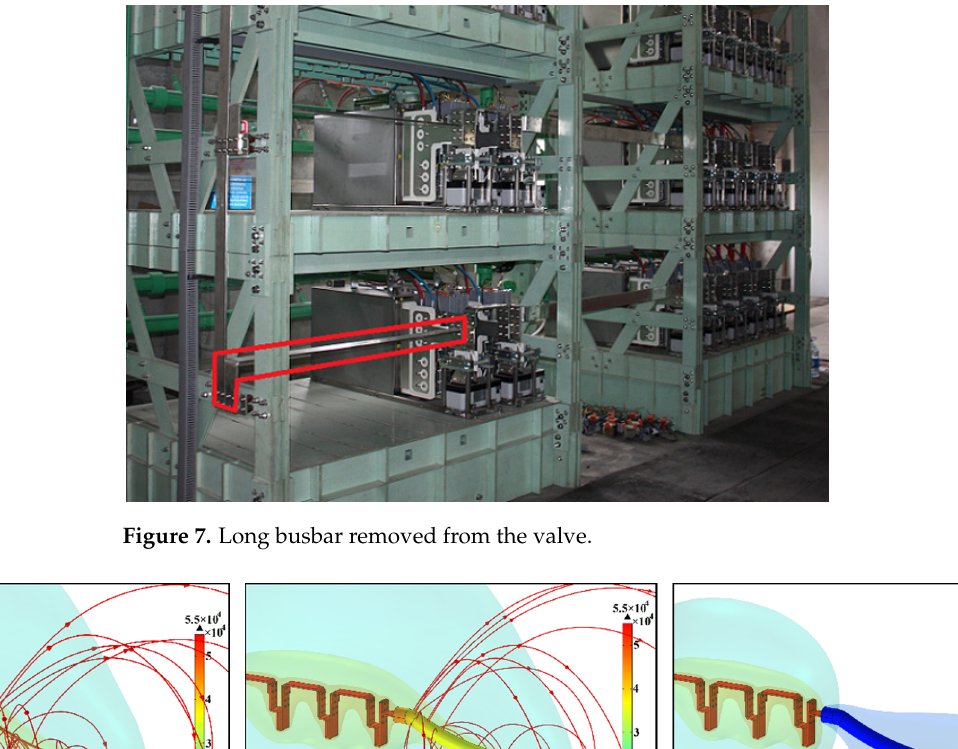
Figure 7. Long busbar removed from the valve.